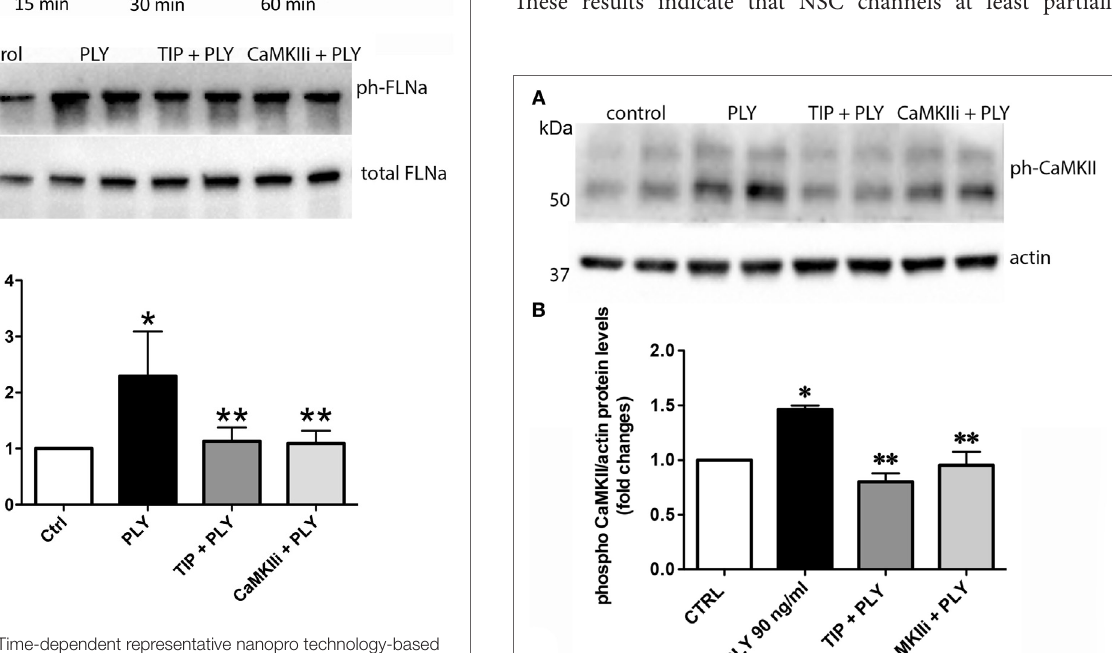
FigUre 3 | (a) Time-dependent representative nanopro technology-based western blot of PLY-induced filamin A (FLN-A) phosphorylation in human lung microvascular endothelial cells (HL-MVEC) (100 and 200 ng/ml), as described (28). (B) Representative western blot. (c) Quantification of phospho- over total protein ratio of PLY (60 ng/ml)-mediated FLN-A phosphorylation in HL-MVEC after 20 min. Cells were either pretreated with TIP peptide (50 µg/ml) or the CaMKII inhibitor (1 mM) for 15 min. Values are presented as means ± SD of three independent experiments in duplicates (* p < 0.05 versus ctrl, ** p < 0.05 versus